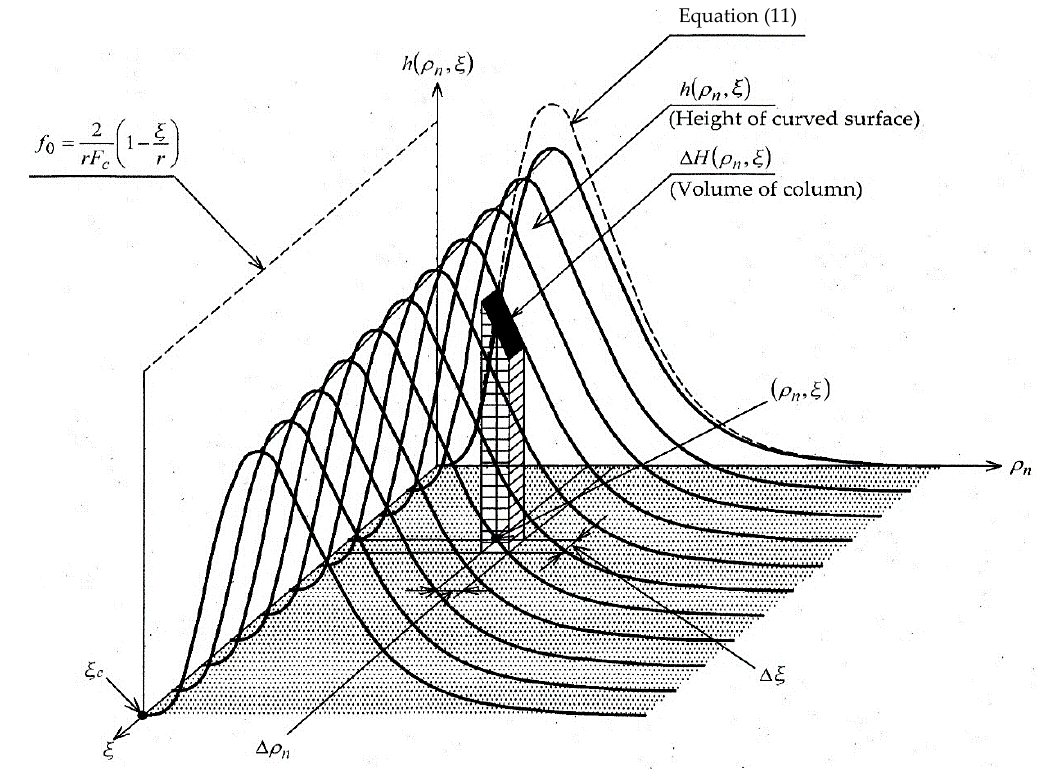
Figure 7. Schematics of joint probability density function of 𝜌 𝑛 and 𝜉 .